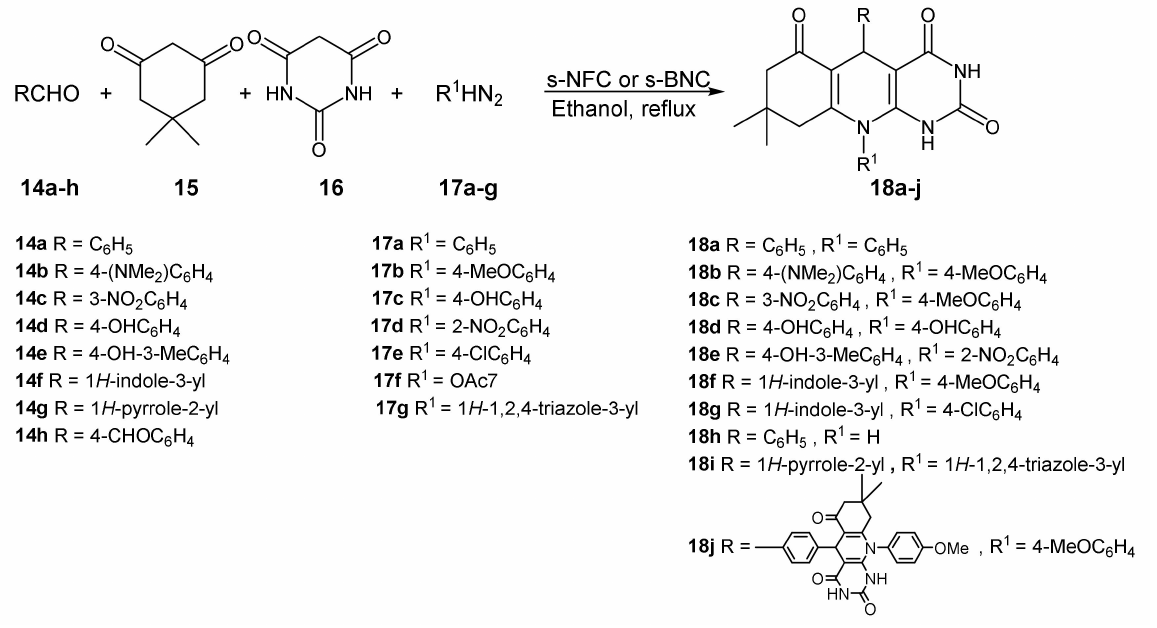
Scheme 6. Multicomponent reaction catalyzed by s-BNC and s-NFC.